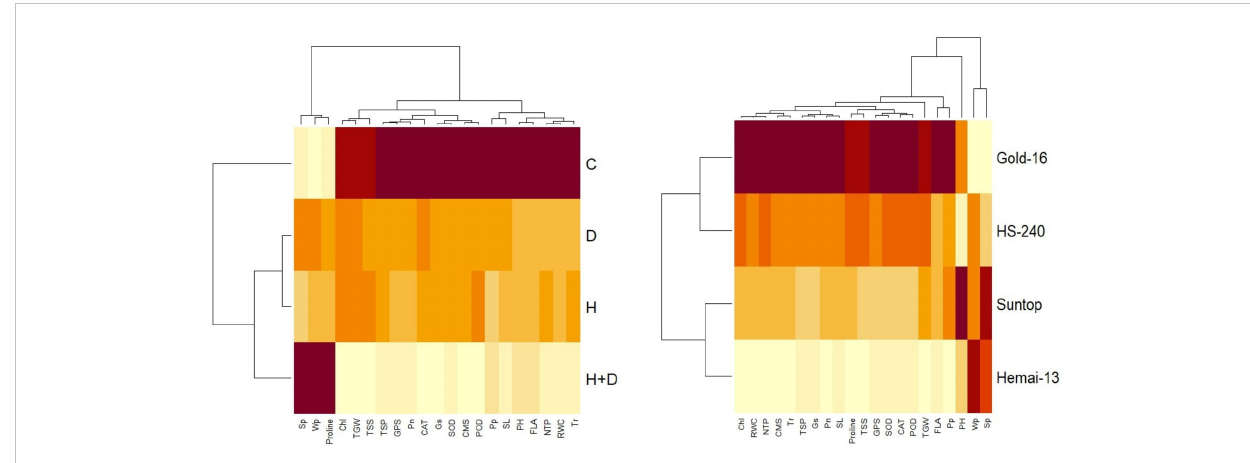
FIGURE 7 Heatmap cluster analysis depicting varying expression and association patterns of biochemical contents, physiological attributes, plant – water relations, and agronomic traits of wheat cultivars (right) and individual and combined treatments of heat and drought stress (left). Superoxide dismutase (SOD); catalase (CAT); peroxidase (POD); total soluble proteins (TSPs); total soluble sugars (TSSs); photosynthesis rate (Pn); transpiration rate (Tr); cell membrane stability (CMS); stomatal conductance (Gs); water potential (Wp); osmotic potential (Sp); pressure potential (Pp); relative